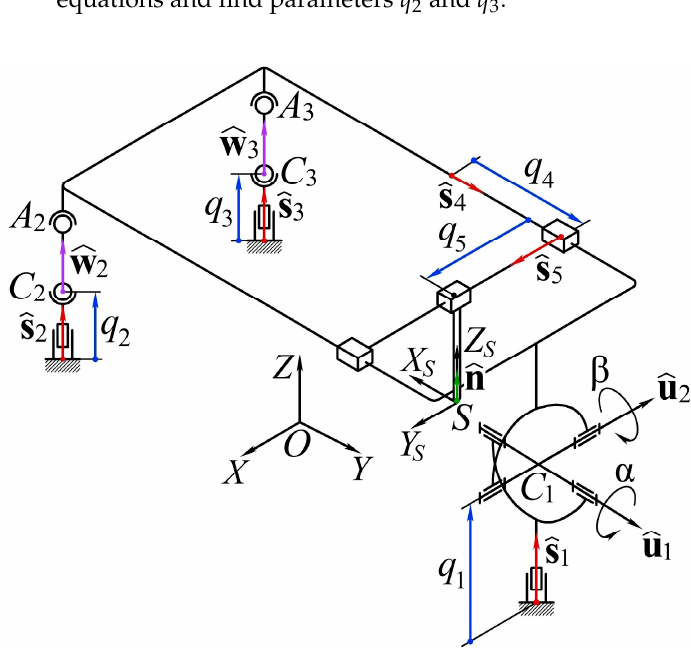
Figure 2. Kinematic analysis of the considered manipulator.